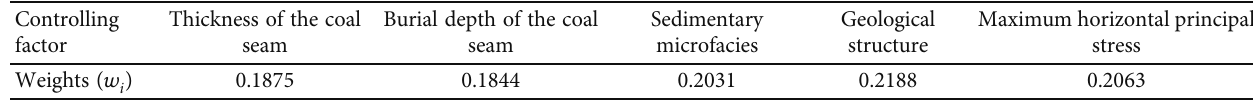
Table 1: Calculate the weight result by FAHP method.